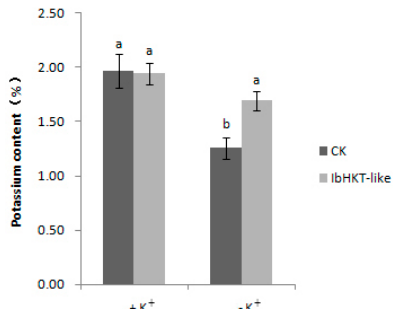
Figure 5. Total potassium content of CK plants and plants with IbHKT-like overexpressing roots under potassium deficiency treatments. The total potassium content of the plant shown as a percentage is on the ordinate. Values indicated the mean and standard deviation of biological repetitions ( n = 8): the same letter indicated no significant difference; different letters indicated extremely significant p < 0.05. CK—CK plants; IbHKT-like— plants with IbHKT-like overexpressing roots.